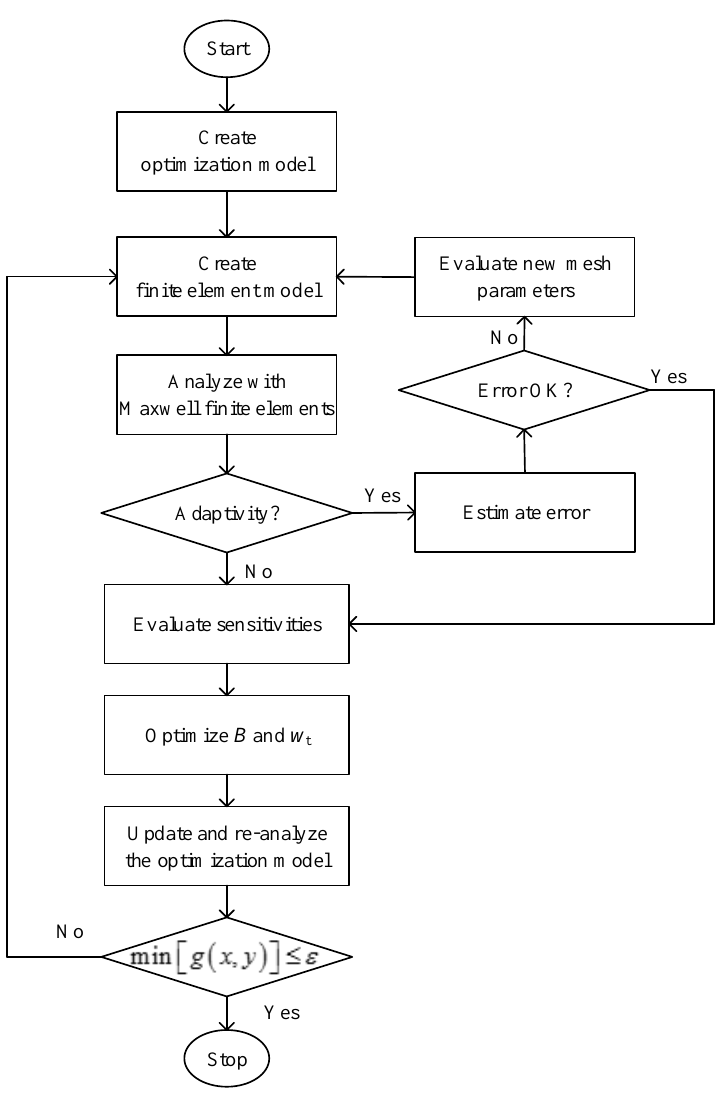
Figure 1. Flowchart of the optimization algorithm with level set evolution.